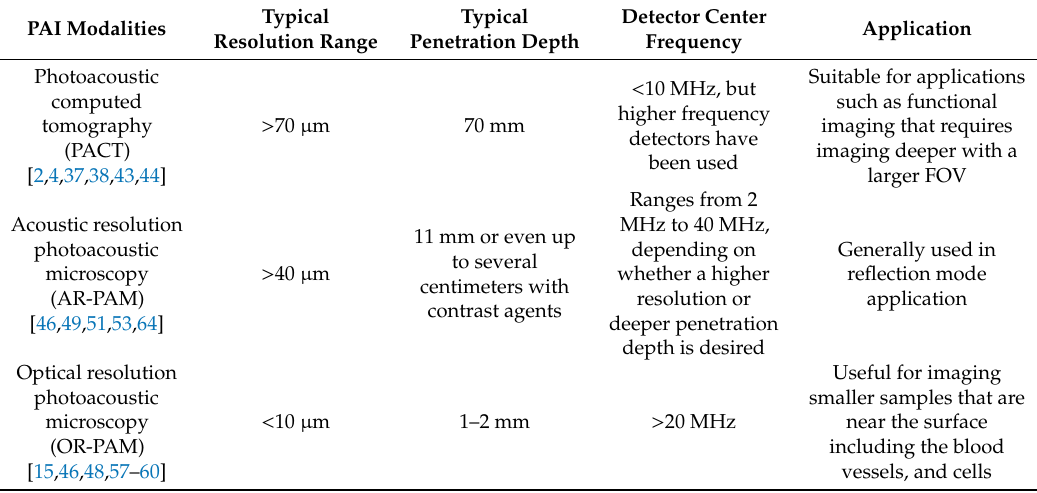
Table 1. The resolution, penetration depth, detector center frequency, and applications for the di ff erent photoacoustic imaging (PAI)